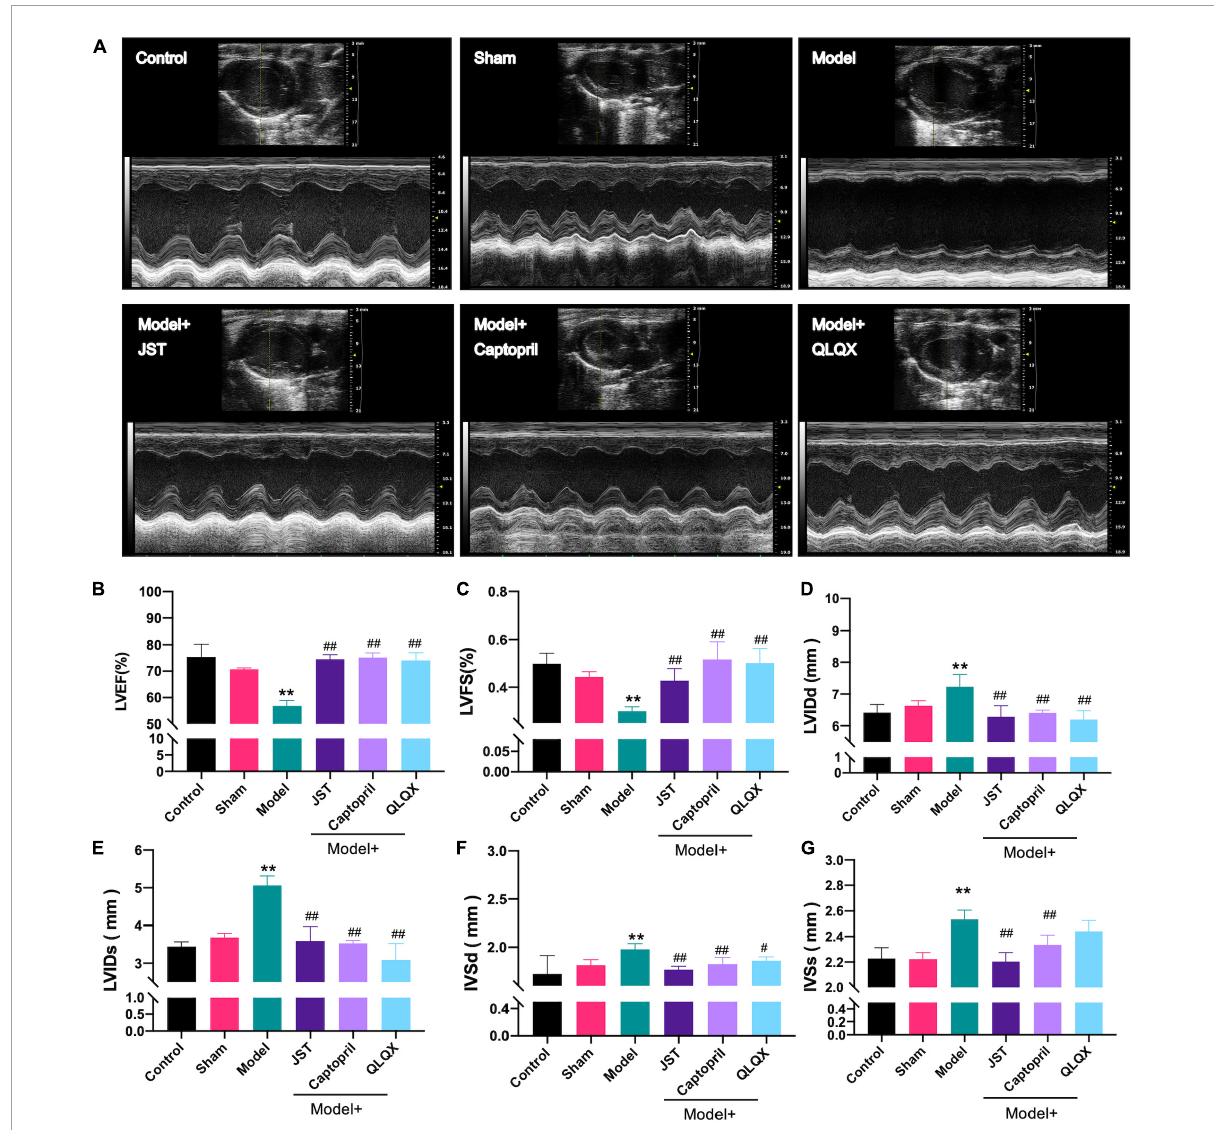
FIGURE2 Effects of JST on cardiac function of heart failure rats. Representative M-mode echocardiography images from experimental rats (A) and the statistical echocardiographic values, including LVEF (B) , LVFS (C) , LVIDd (D) , LVIDs (E) , IVSDd (F) , and IVSDs (G) . All data were expressed